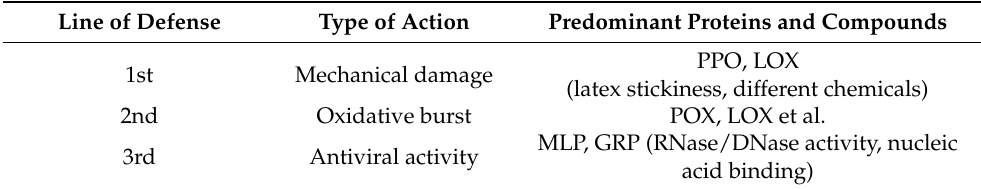
Table 2. Model of antiviral response of Chelidonium majus latex based on in vitro studies, which represents preformed immediate defense response with exuding latex. 1st line of defense-after mechanical damage (e.g., herbivore bite) the latex exudes and due its stickiness clots and stops or kills the herbivore. 2nd line of defense-cell wall damage is the prerequisite for the possibility of viral infection. Thereafter it can be stopped by oxidative burst and antiviral response (3rd line of defense). Abbreviations: PPO–polyphenol oxidase; LOX-lipoxygenase; POX-peroxidase; MLP-major latex protein; GRP-glycine-rich protein. According to [74]. Line of Defense Type of Action Predominant Proteins and Compounds PPO, LOX 1st Mechanical damage (latex stickiness, different chemicals) 2nd Oxidative burst POX, LOX et al. MLP, GRP (RNase/DNase activity, nucleic 3rd Antiviral activity acid